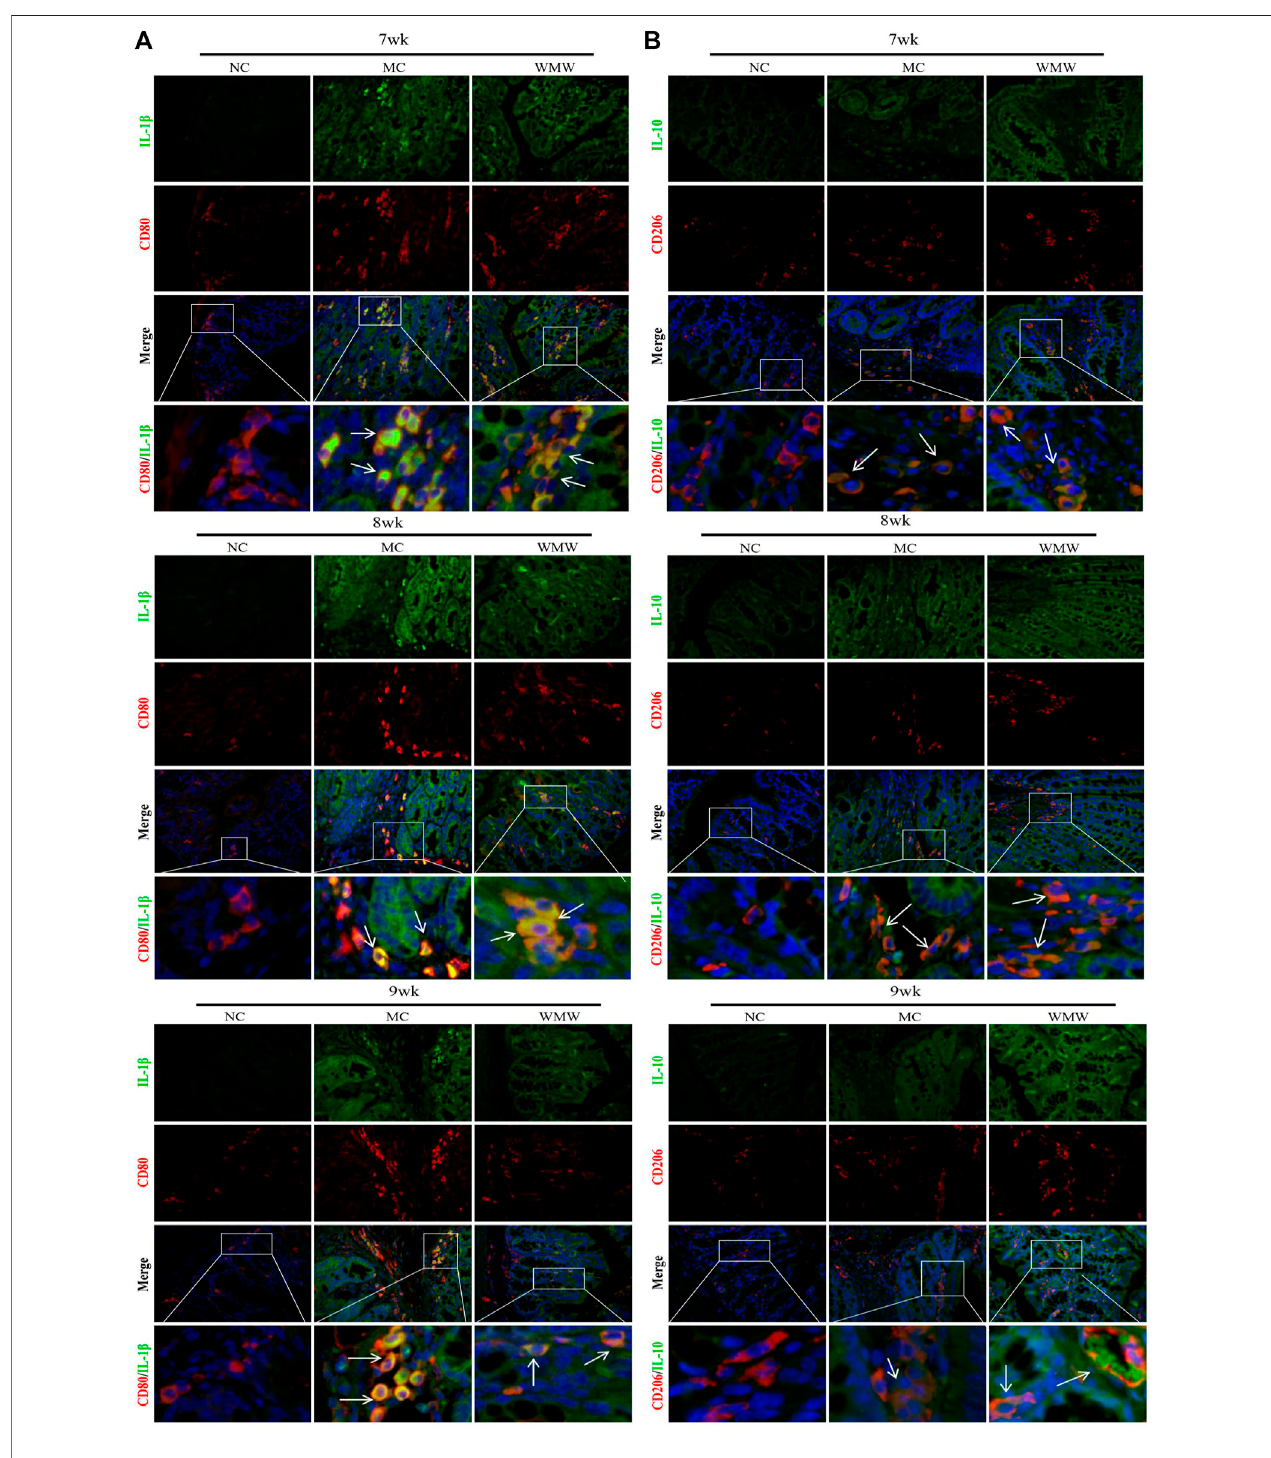
FIGURE 6 | The proportion of M1/M2 macrophages changes in colon sections obtained from mice with ulcerative colitis induced by DSS (A) Double immuno fl uorescent signals from CD80 and interleukin-1 in DSS-induced colitis tissue at different time points (original magni fi cation, 200 ×). (B) Double immuno fl uorescent signals from CD206 and interleukin-10 in DSS-induced colitis tissue at different time points (original magni fi cation, 200 ×).